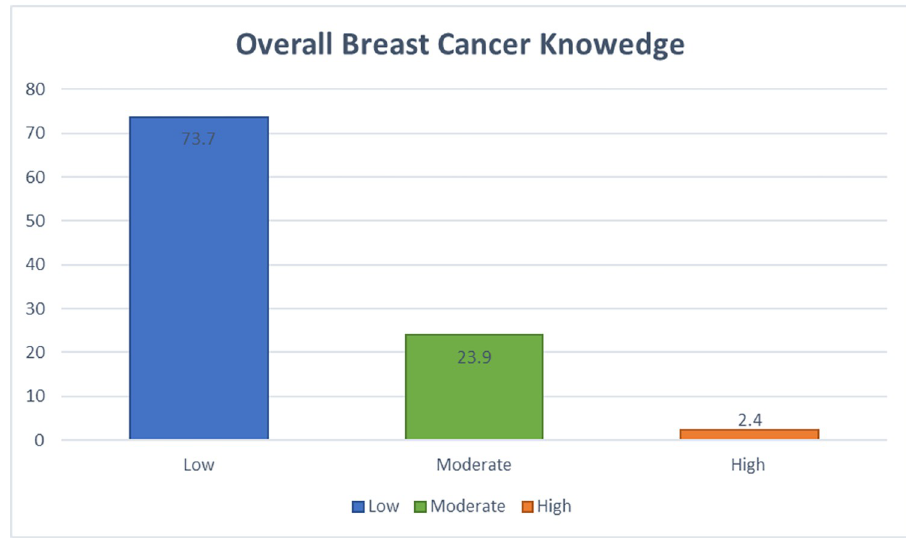
Fig 1. Young adult women’s knowledge of breast cancer Gurage